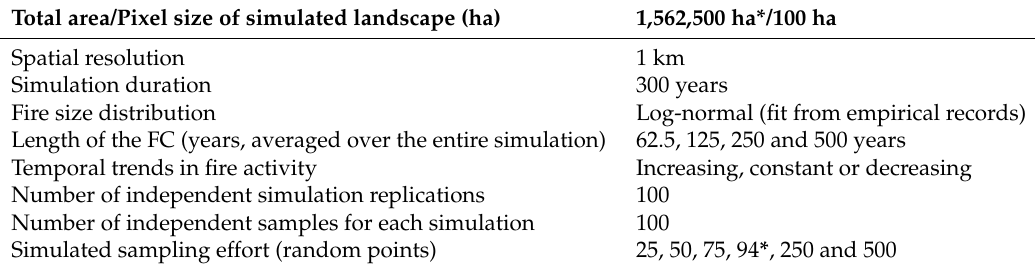
Table 1. Summary of simulation parameters.